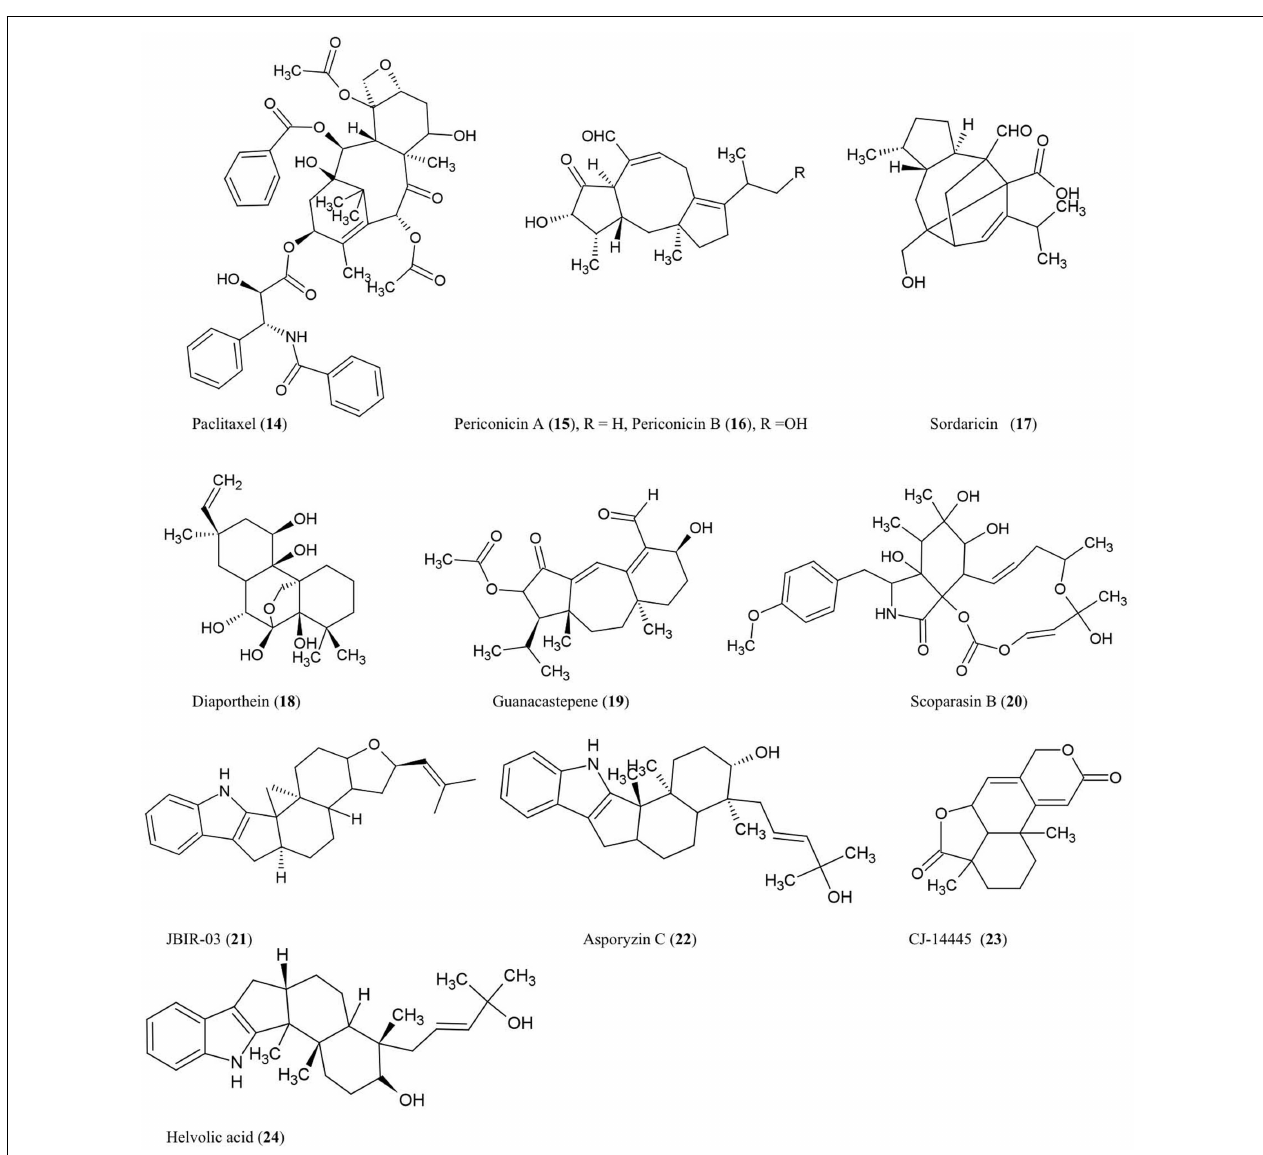
FIGURE 2 | Structures of diterpene and triterpene derivatives of fungal endophyte origin (14–24).